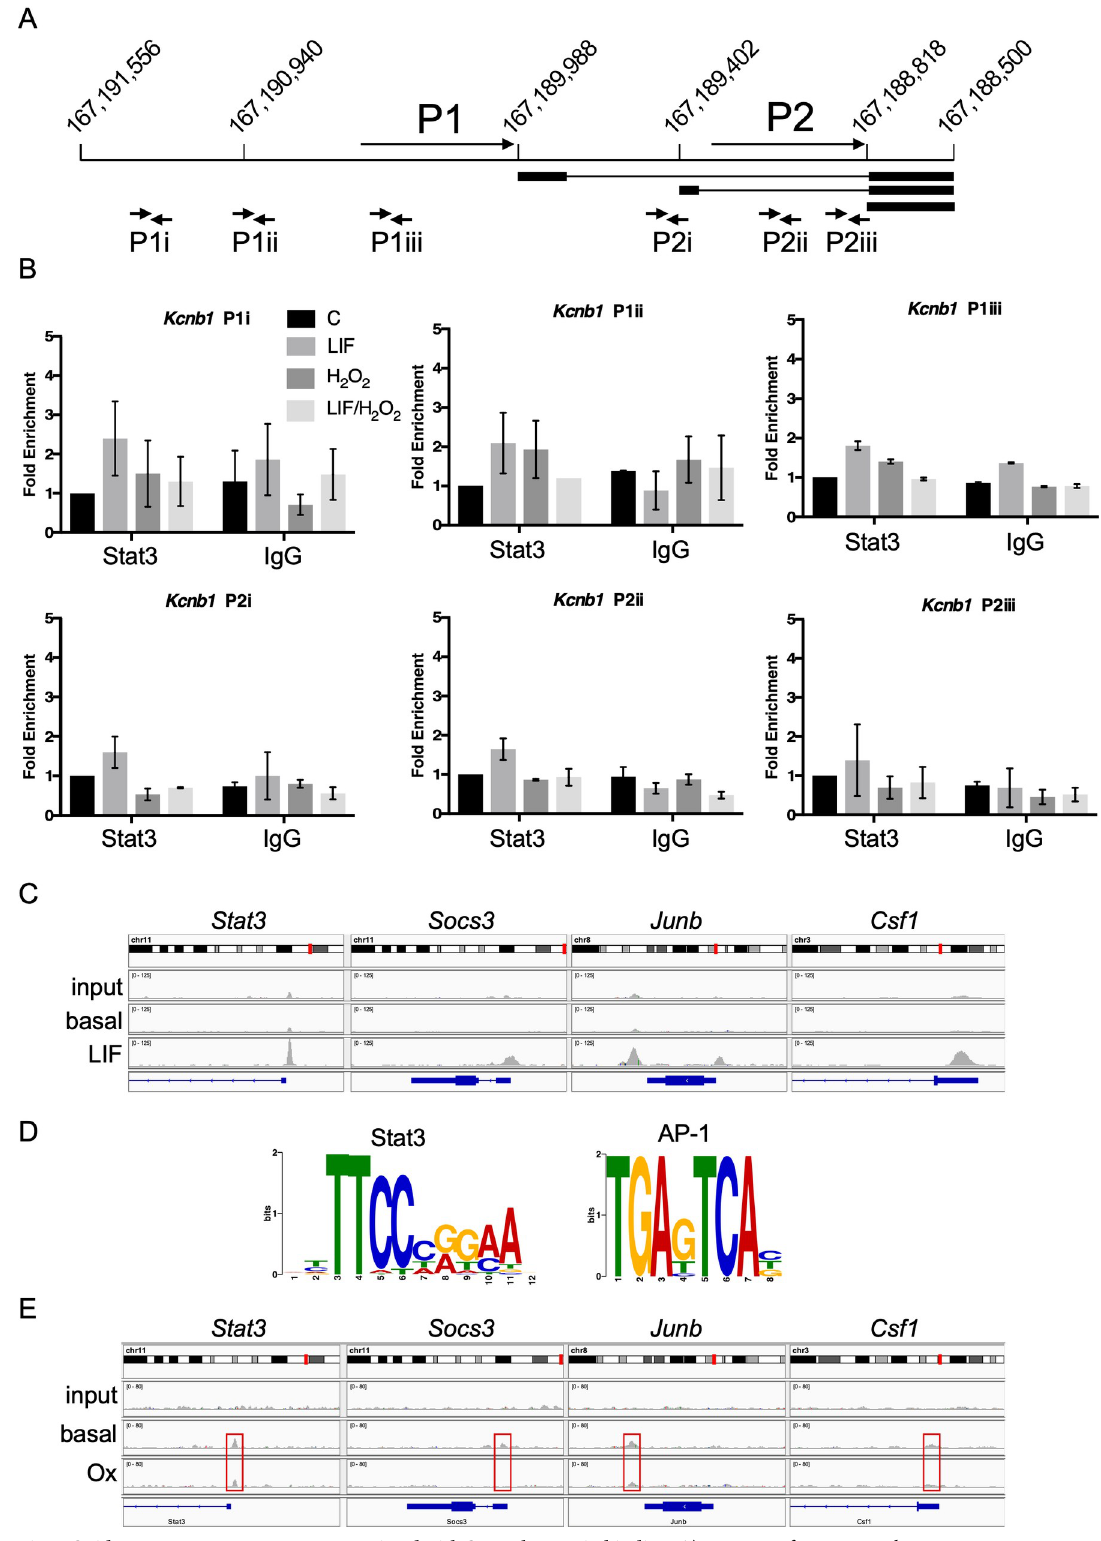
Fig 4. Oxidant-response genes are not associated with Stat3 chromatin binding. A) Diagram of murine Kcnb1 gene promoter region on chromosome 2 with coordinates above horizontal line. Transcripts from P1 and P2 promoters are indicated with exons as bars